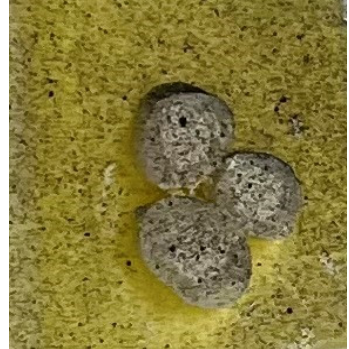
Figure 2. Sprayed samples.